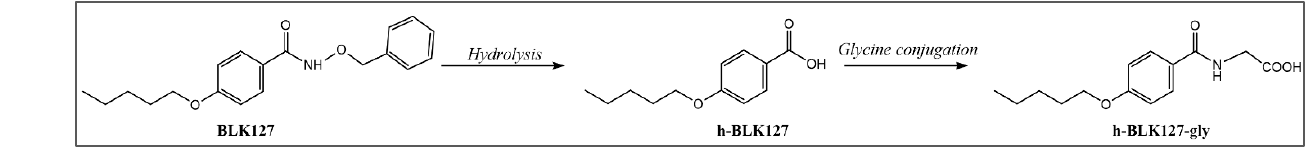
Figure 7. The proposed metabolic pathways of compound BLK127 in H. contortus adults.